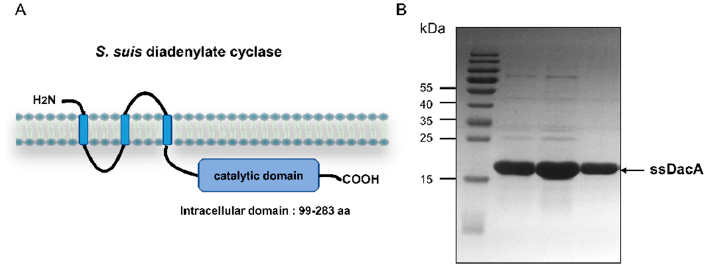
Figure 1. Purification of the catalytic domain of diadenylate cyclase of S. suis . ( A ) The predicted topology of S. suis diadenylate cyclase; ( B ) SDS-PAGE analysis of purified ssDacA.